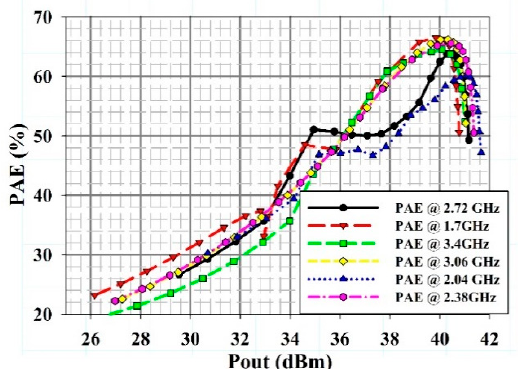
Figure 16. Simulated power-added efficiency (PAE) versus P out for the proposed Doherty output combiner.